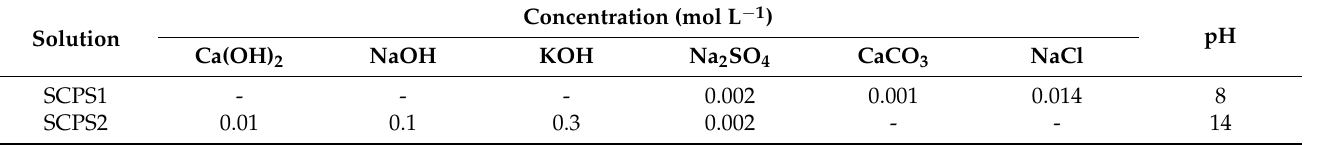
Table 1. Composition and pH of carbonated (SCPS1) and alkaline (SCPS2)-simulated concrete pore